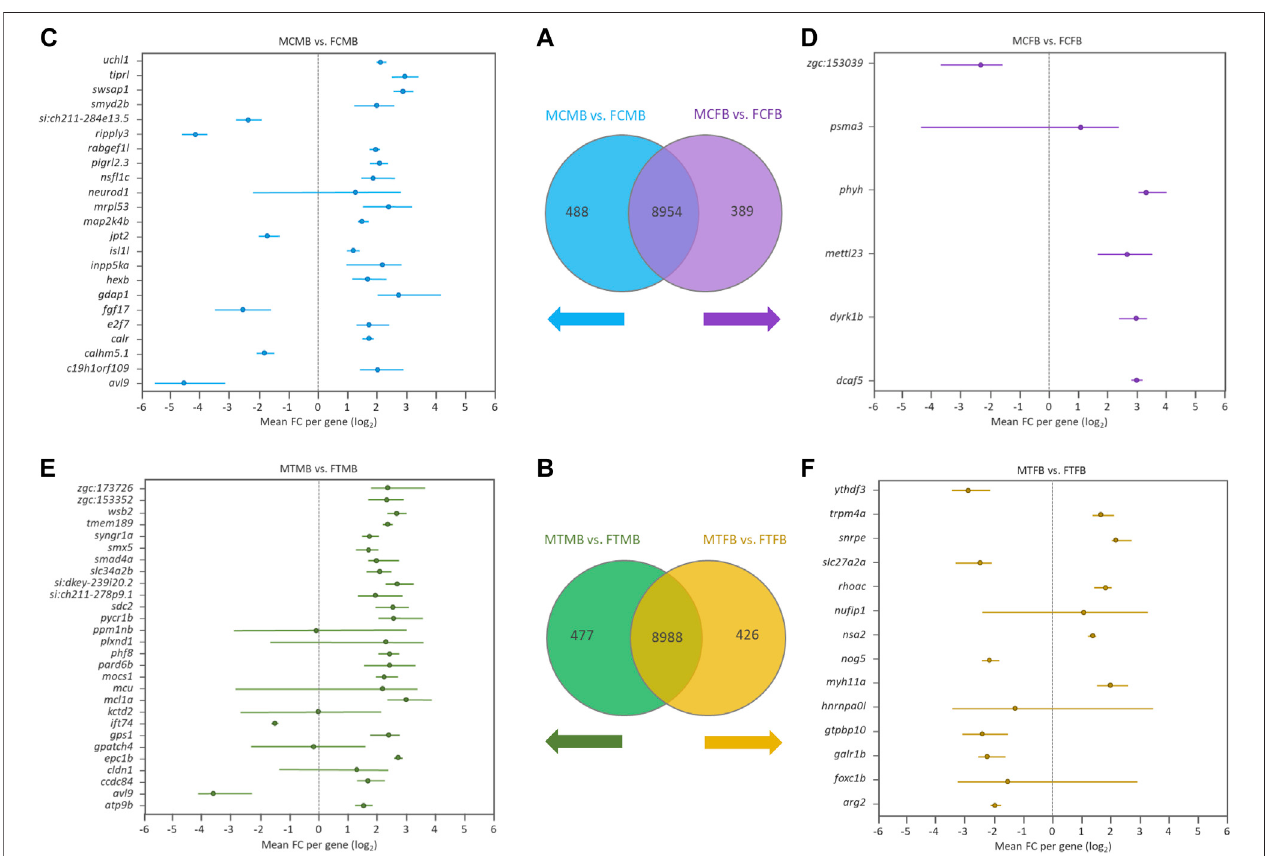
FIGURE 7 | Genes associated with the signi fi cantly differentially methylated CpG sites comparing testes versus ovaries within sex-biased families. Venn diagrams illustrate the differences between the male-biased and the female-biased families in the control (A) and treatment (B) groups. Forest plots represent the unique genes in each sex-biased family, as classi fi ed in the Venn diagram, associated with the differentially methylated sites, indicating a range of at least four methylated positions ( fi fth percentile of distribution) in different experimental groups: (C) male control male-biased versus female control male-biased (MCMB vs. FCMB); (D) male control female-biased versusfemale controlfemale-biased(MCFBvs.FCFB); (E) maletreatmentmale-biasedversusfemaletreatmentmale-biased(MTMB vs. FTMB); (F) male treatment female-biased versus female treatment female-biased (MTFB vs. FTFB). The x -axis represents the differences mean fold change (log 2 FC) per gene.